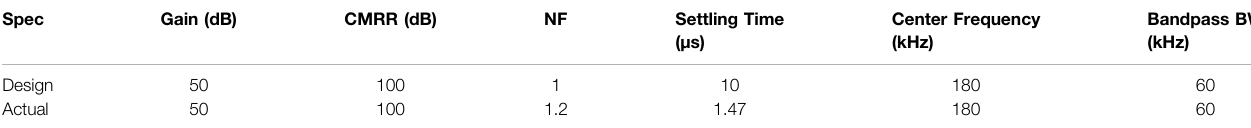
TABLE 2 | LNA Design Spec vs. Actual.